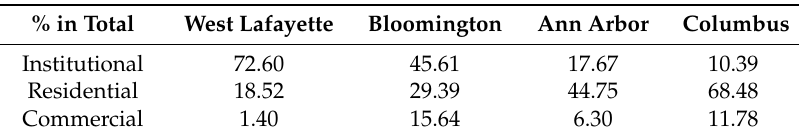
Table 4. Percentage of Tweets in various land